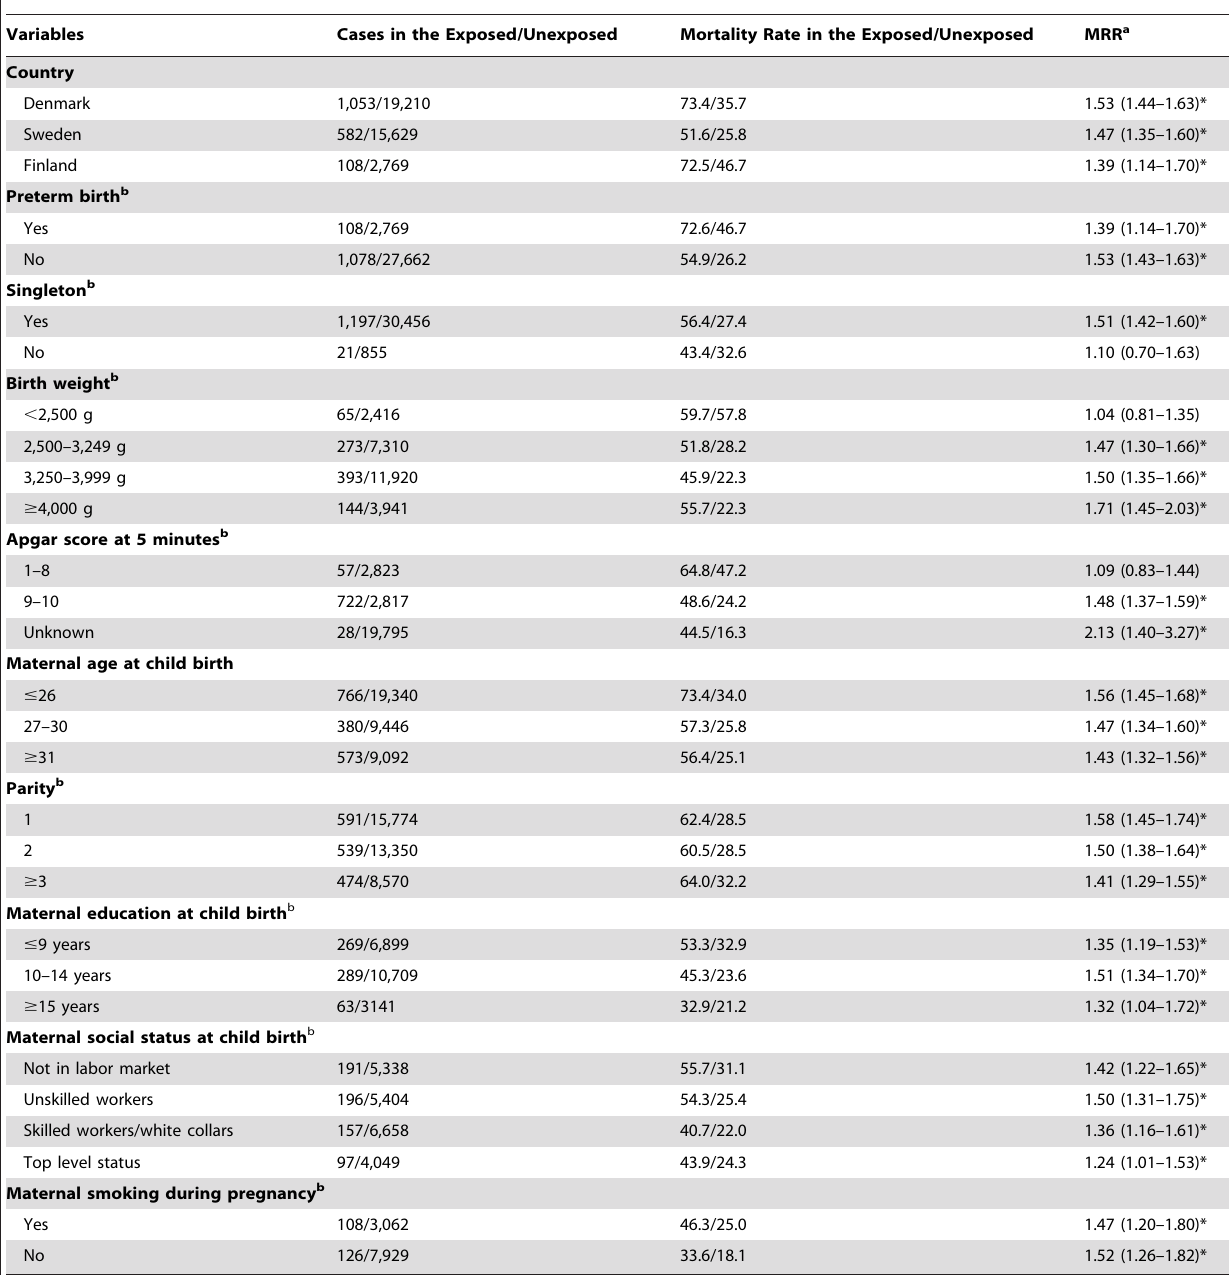
Table 4. Mortality rate ratios according to characteristics of study